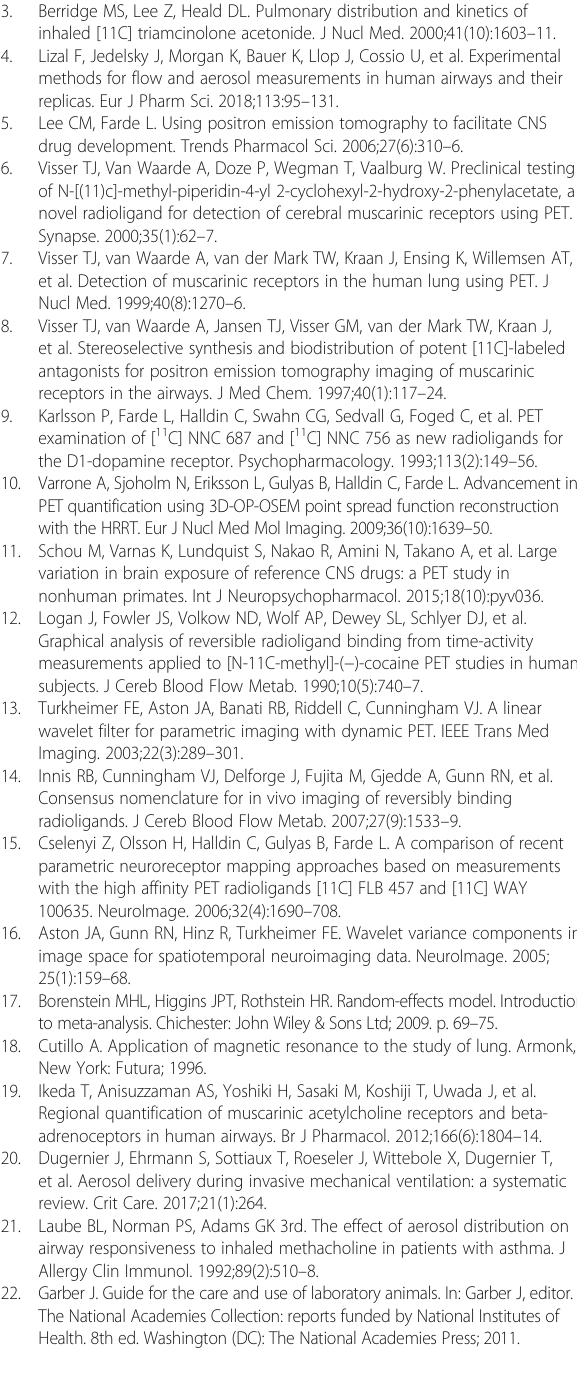
intravenous administration. Figure S5. PET images from each experimen- tal session. Figure S6. Time-course for radioactivity in venous and